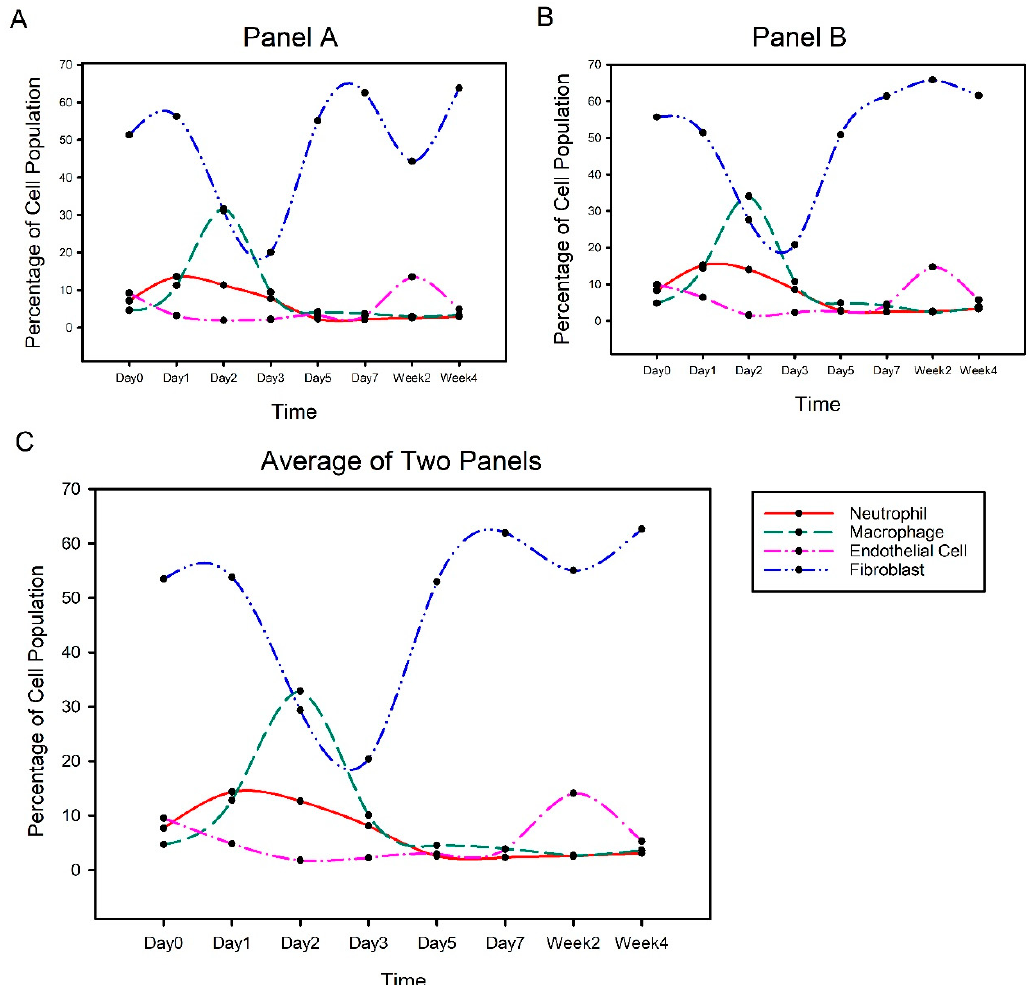
Figure 2. Percentage of each cell type over time in Panel A and B with gating method. Behaviour of four cell types in two different panels: ( A ) Panel A and ( B ) Panel B. ( C ) Combination of two panels listed above in one curve.